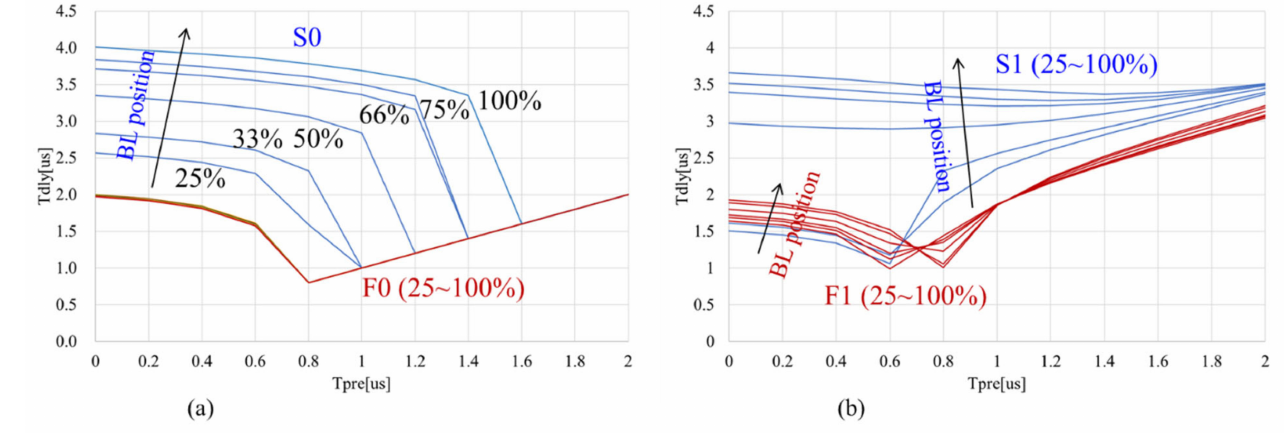
Figure 9. Address dependency of the sensed current delay in the fastest case ( a ) and the slowest case ( b ) with the three-line model.